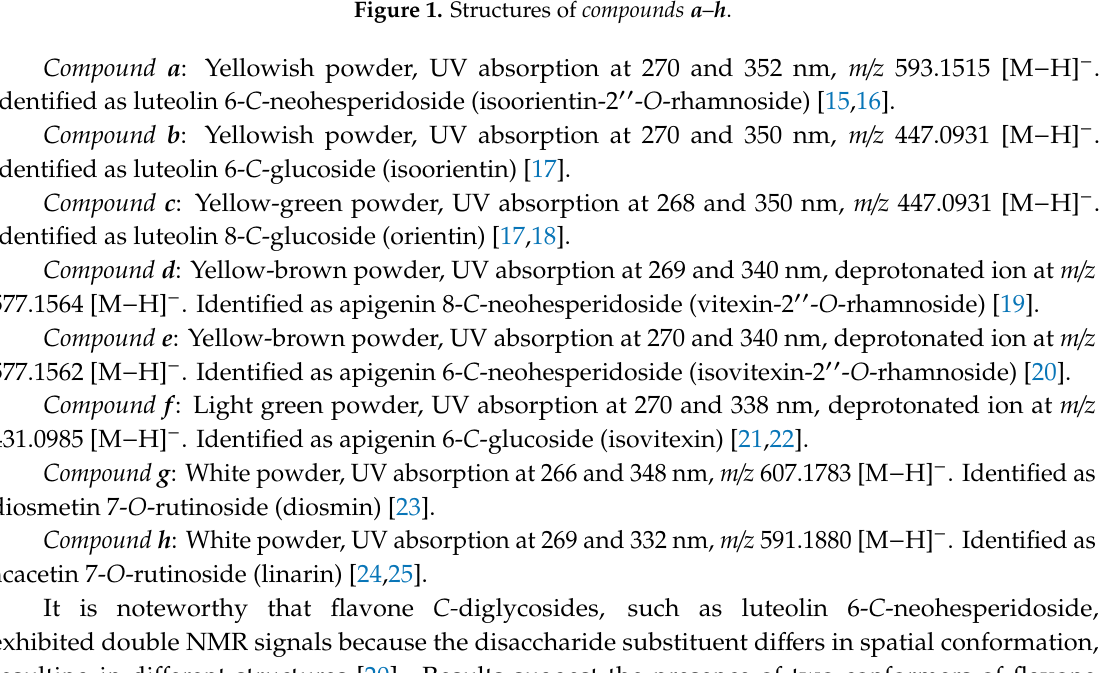
Figure 1. Structures of compounds a – h .